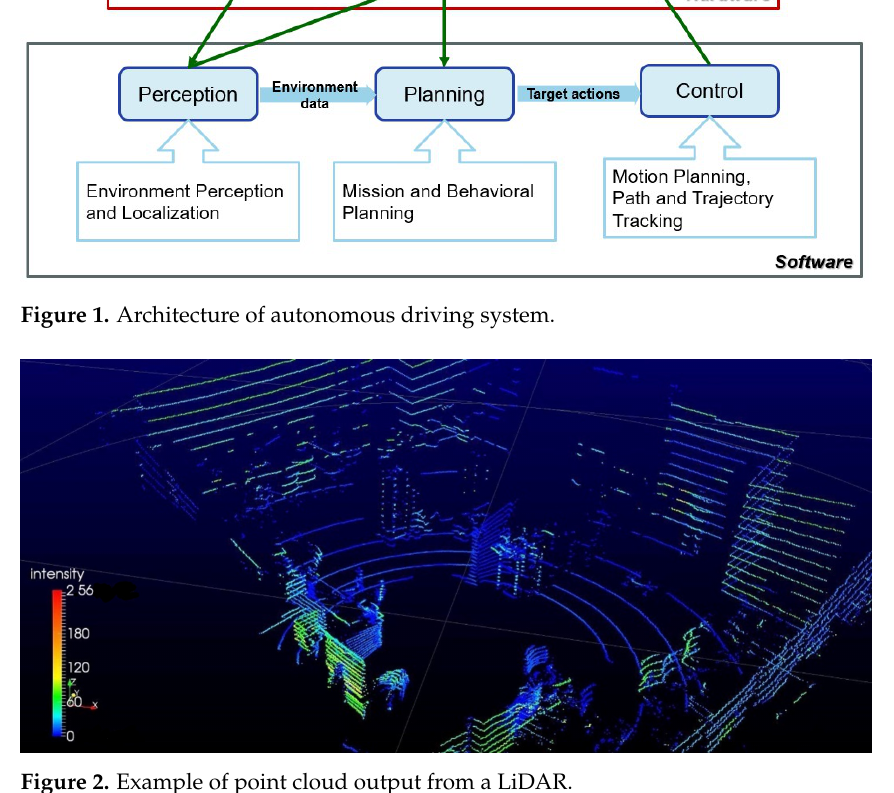
Figure 2. Example of point cloud output from a